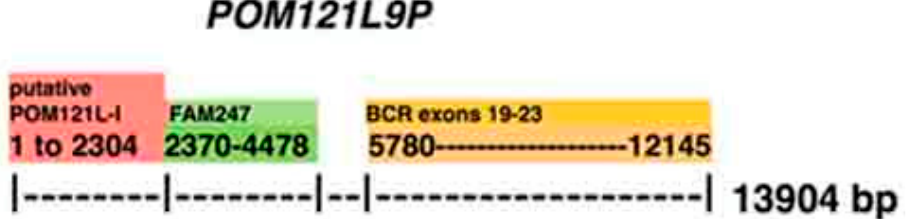
Figure 8. A schematic of the compositional make-up of the pseudogene POM121L9P . The numbers under the motifs shown represent the bp positions on the POM121L9P sequence. The FAM247 sequence that forms part of POM121L9P consists of FAM247 positions 5949–8219, where there are Alu sequences at both ends.